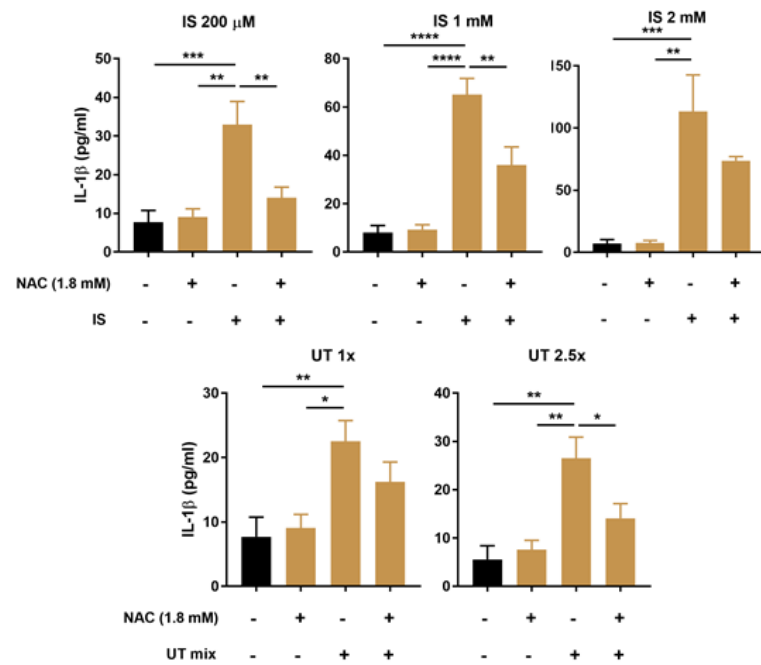
Figure 4. Effect of PBUTs-induced oxidative stress on caspase-1 activity and IL-1 β production in ciPTEC-OAT1. ( A ) Relative intracellular ROS production in ciPTEC-OAT1 after 2 h exposure to IS (200 µ M, 1 mM, 2 mM), UT mix (1 × , 2.5 × ) and H 2 O 2 (200 µ M, positive control), in the absence or presence of ROS inhibitor NAC (1.8 mM). ( B ) Relative caspase-1 activity in ciPTEC-OAT1 following 2 h exposure to IS (200 µ M, 1 mM, 2 mM) and UT mix (1 × , 2.5 × ), in the absence or presence of NAC (1.8 mM). ( C ) IL-1 β secreted levels (pg/mL) by ciPEC-OAT1 upon 24 h treatment with IS (200 µ M, 1 mM, 2 mM) and UT mix (1 × , 2.5 × ), in the absence or presence of NAC (1.8 mM). Data are derived from at least three independent experiments performed in triplicate and expressed as mean ± SEM. * p < 0.05, ** p < 0.01, *** p < 0.001, **** p < 0.0001 (One-way ANOVA followed by Dunnett’s multiple comparison test, using PBUTs treated cells as a